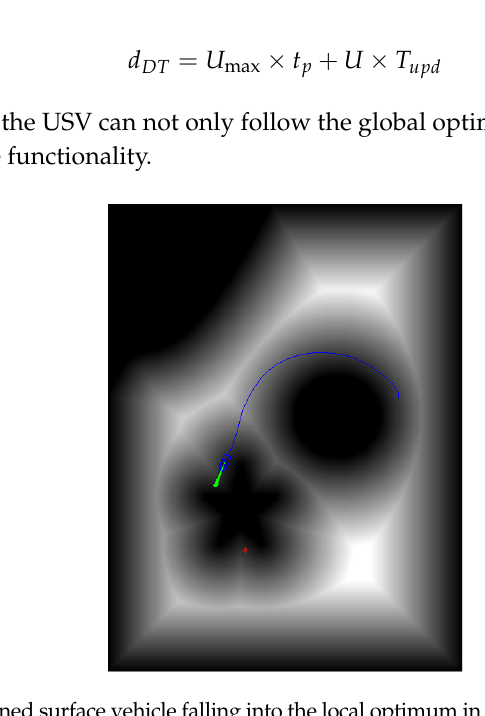
Figure 11. The unmanned surface vehicle falling into the local optimum in a static simulation